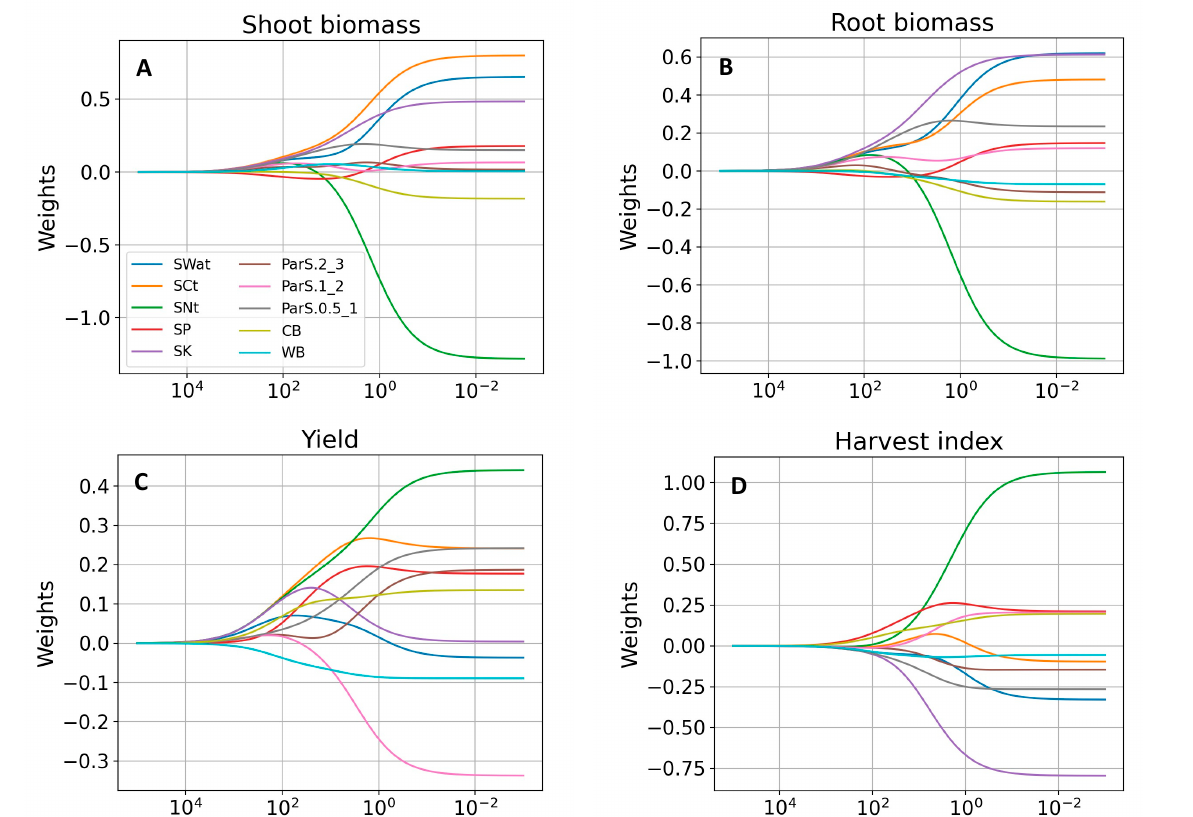
Figure 7. Ridge trace plots for estimates of data regression of plant growth indicators (( A ) shoot biomass, ( B ) root biomass, ( C ) grain yield, and ( D ) harvest index). Weights represents regression coefficient, Alpha represents tuning parameter.